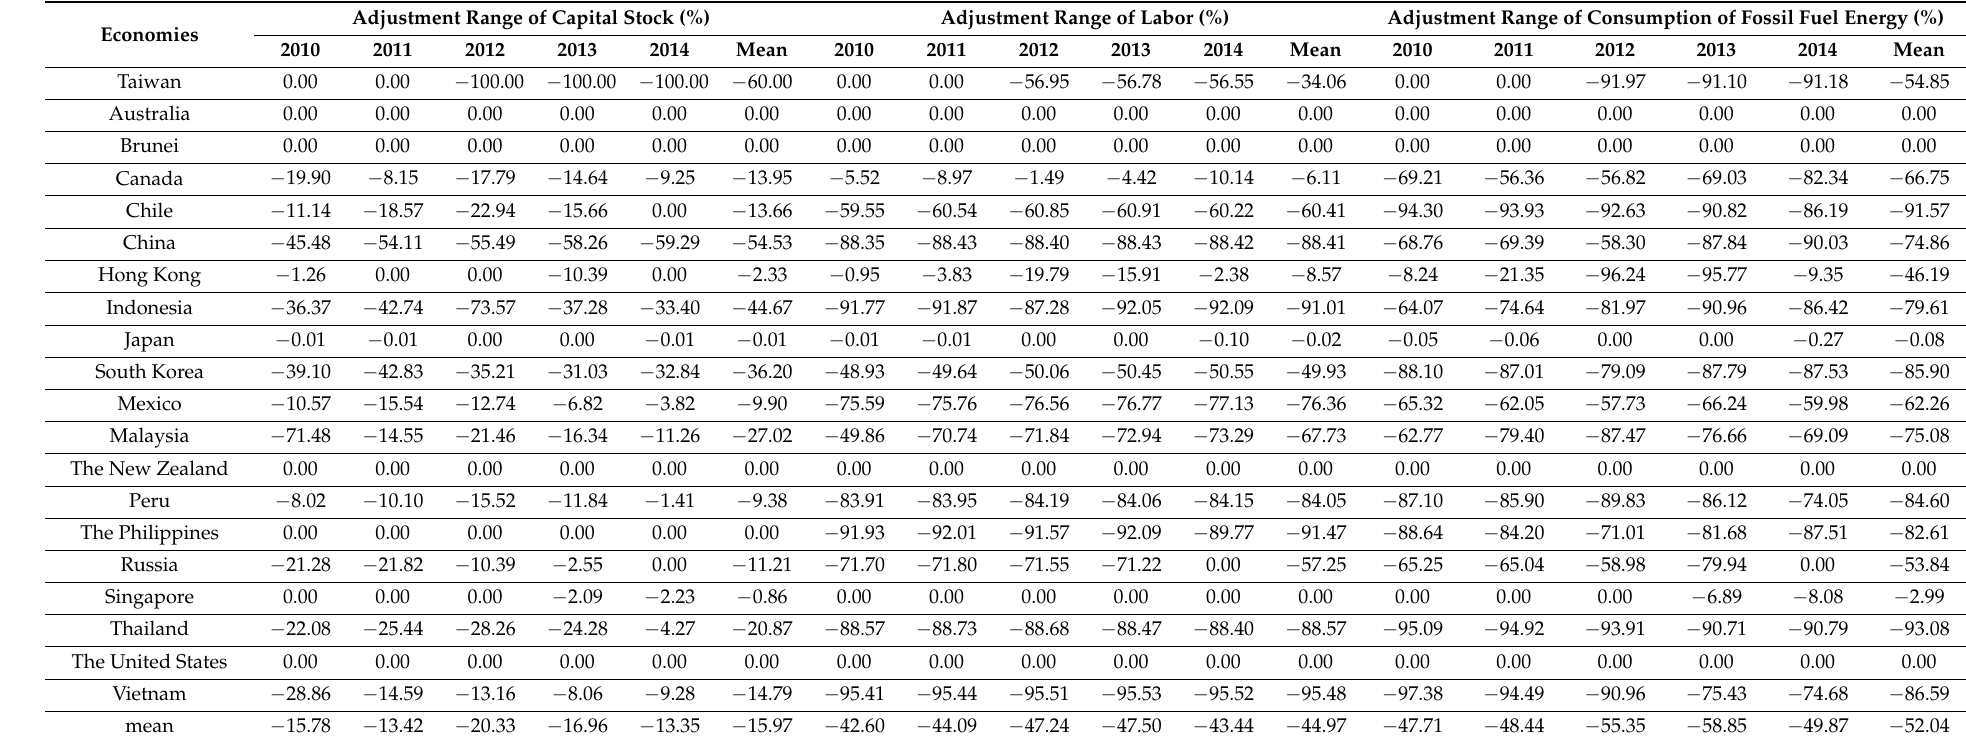
Table 7. The adjustment of input items for AEPC economies from 2010 to